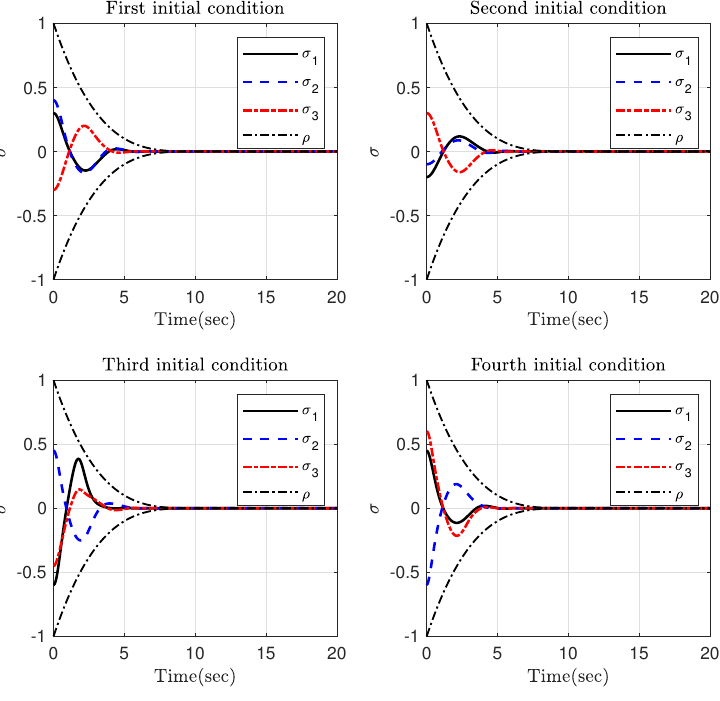
Figure 4. Time responses of the attitude in Part 1 for different initial conditions.